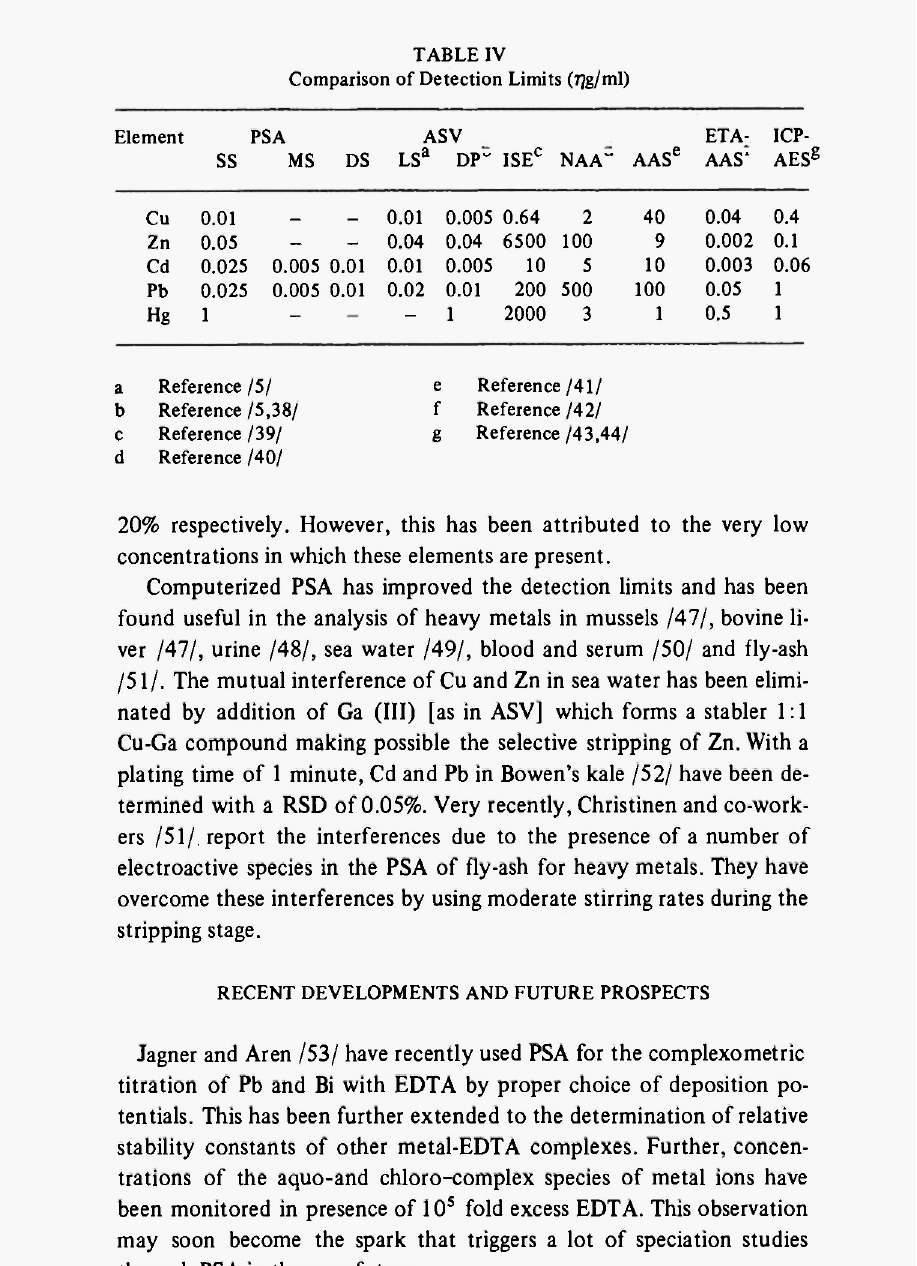
TABLE IV Comparison of Detection Limits